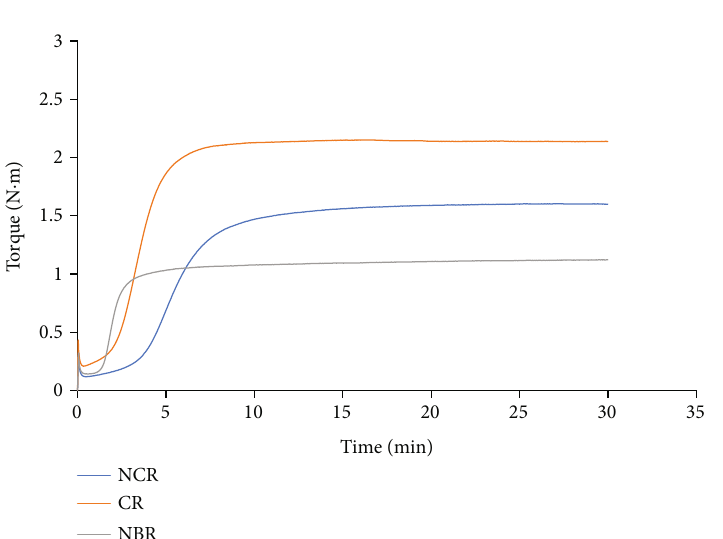
Figure 4: Rheometric cure curves of compounds of acrylonitrile-chloroprene rubber (NCR), chloroprene rubber (CR), and nitrile rubber (NBR). Table 4: Properties of vulcanizates of